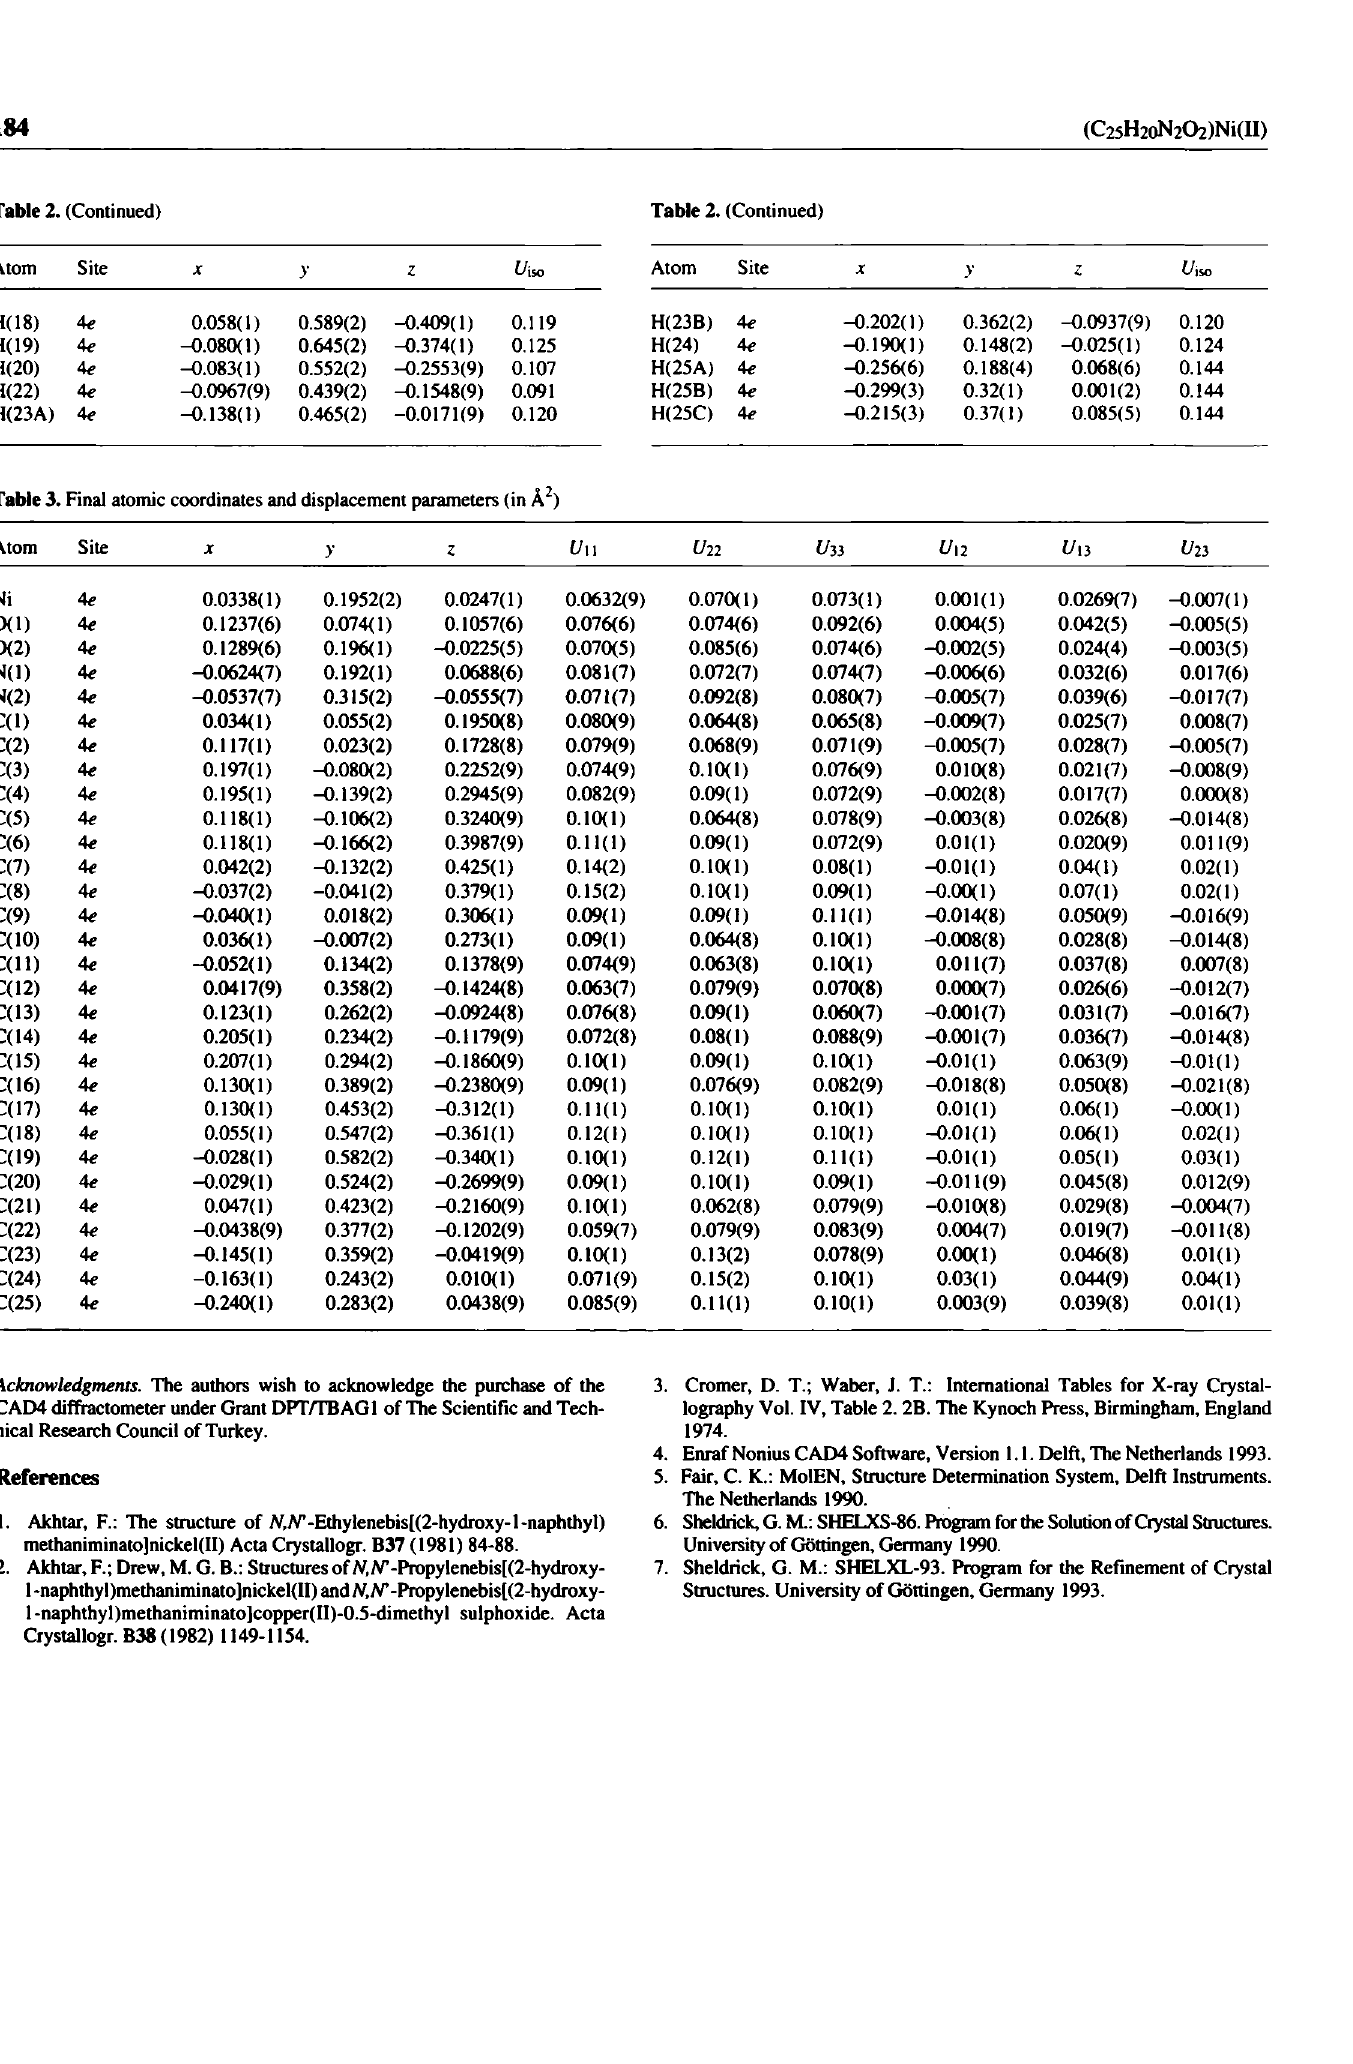
Table 3. Final atomic coordinates and displacement parameters (in Á 2